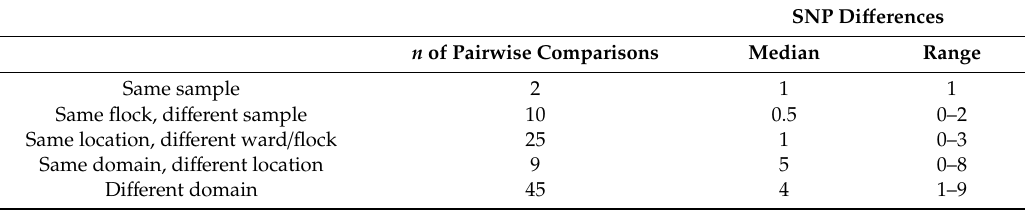
Table 3. Median and range of SNP di ff erences in pairwise comparisons per epidemiological link. SNP Di ff erences n of Pairwise Comparisons Median Range Same sample 2 1 1 Same flock, di ff erent sample 10 0.5 0–2 Same location, di ff erent ward / flock 25 1 0–3 Same domain, di ff erent location 9 5 0–8 Di ff erent domain 45 4